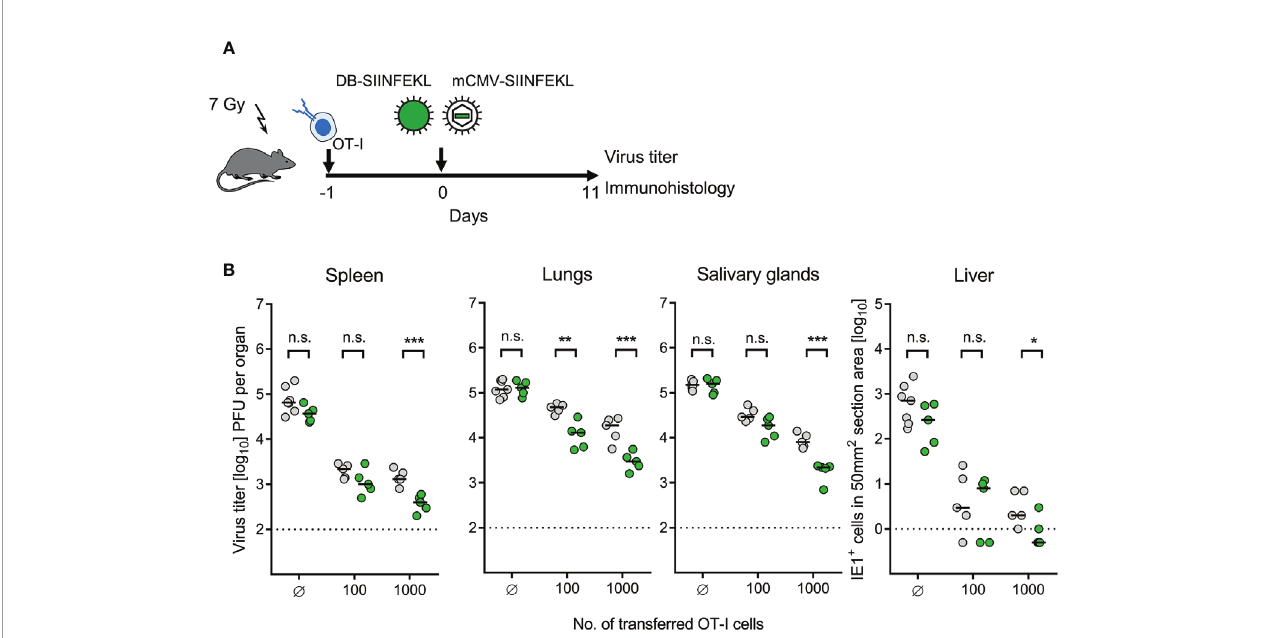
FIGURE 10 | Enhancement of protection by combining ACT with DB-based TherVac. (A) Sketch of the protocol. Immunocompromised C57BL/6 mice received either no ACT for control or ACT with 10 2 or 10 3 OT-I cells. On the following day, intraplantar TherVac with 20 m g of DB-SIINFEKL and infection with 10 5 PFU of mCMV-SIINFEKL were performed combined. Control of organ infection was assessed on day 11. (B) Virus titers in spleen, lungs, and salivary glands, as well as numbers of infected IE1 + liver tissue cells in representative 10-mm 2 section areas. Symbols (grey-shaded closed circles: no vaccination; green closed circles: vaccination with DB-SIINFEKL) represent data from individually tested mice, with the median values marked. Signi fi cance levels (*) P < 0.05, (**) P < 0.01, (***) P < 0.001. (n.s.), not signi fi cant ( P > 0.05). Dotted lines, detection limits of the